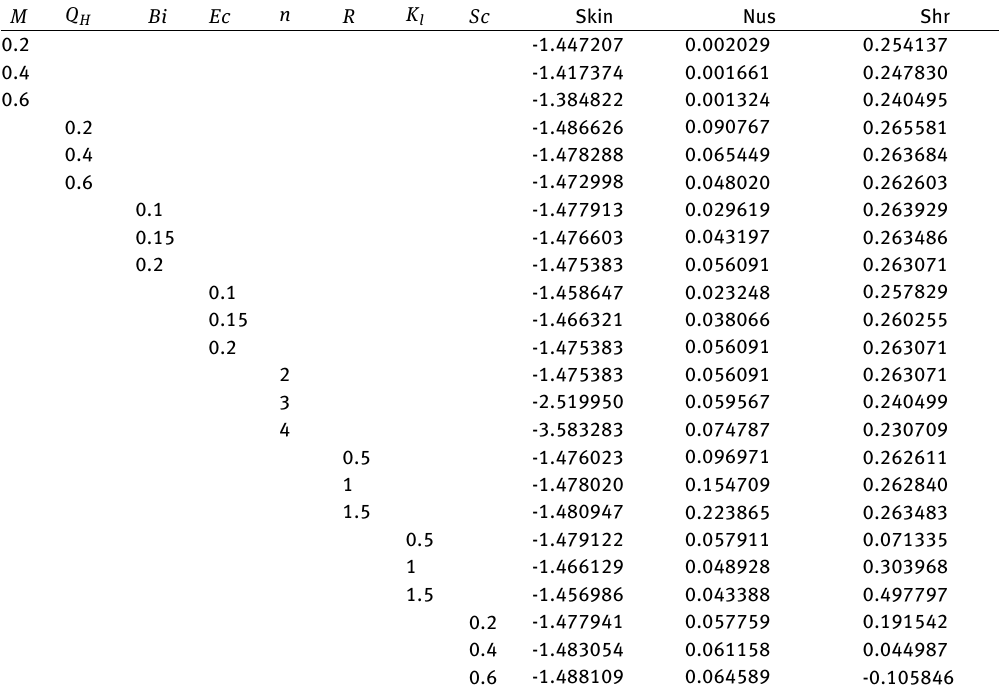
Table 3: The variations of local skin friction, Nusselt and Sherwood numbers for several of M = 0.2, K = 0.2, Gc = Gr = 0.2, N = 0.5, Ec = 0.2, R = 0.1, Sc = 0.1, K = 0.3, n = 2, Q = 0.5, We = 0.2 in f = −0.5 w H l